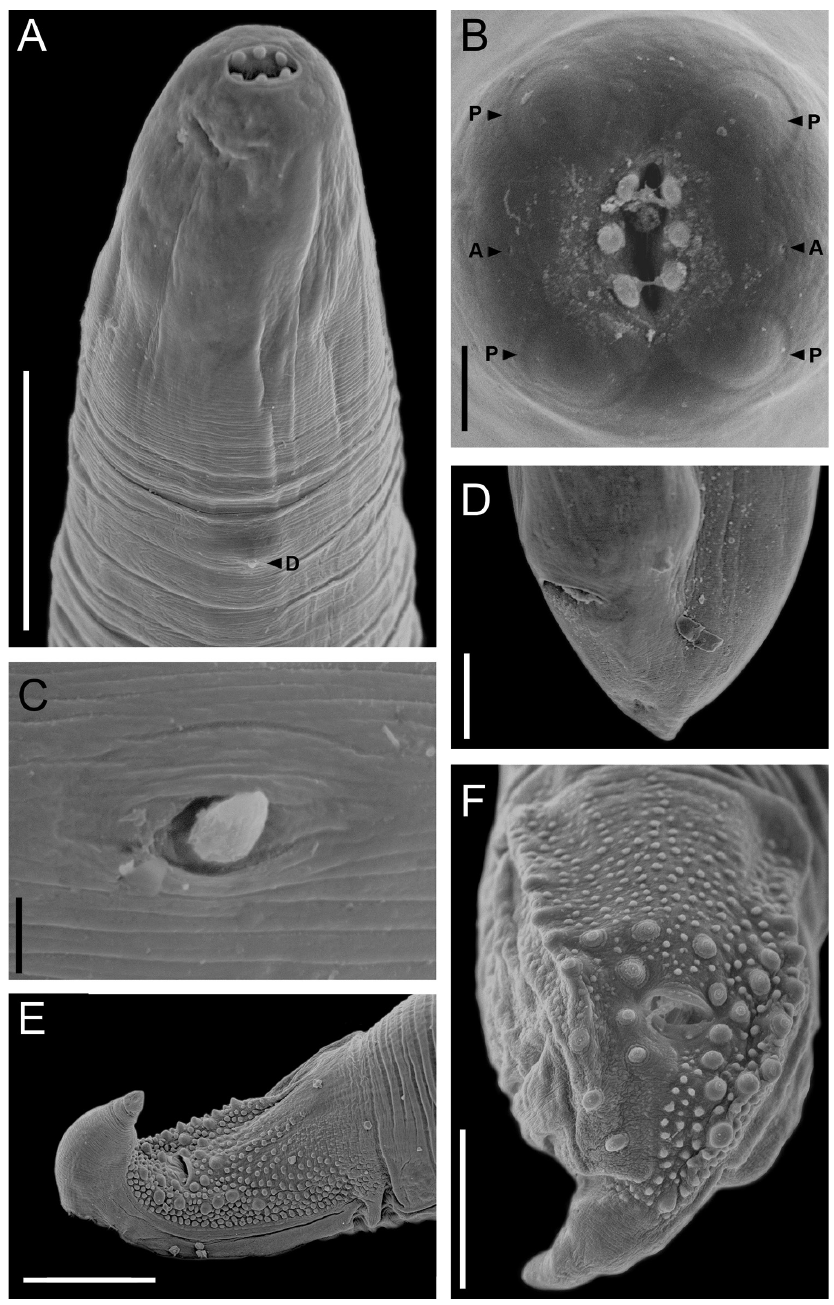
Figure 2. Thubunaea leonregagnonae sp. n. Scanning electron micrographs. A Anterior end, male, lat- eral view showing deirid ( D ) B Apical view, female, showing sub-median papillae ( P ) and amphids ( A ) C Deirid, lateral view D Posterior end, female, ventrolateral view E Posterior end, male, ventral view F Caudal end, male, ventral view. Scale bars: A 50 µm; B 10 µm; C 2.5 µm; D 50 µm; E 100 µm; F 50